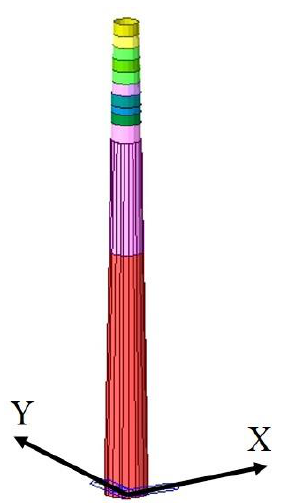
Figure 7. Finite element model (FEM) of the chimney. Table 1. Fundamental frequencies of the chimney, with the corresponding participating masses.